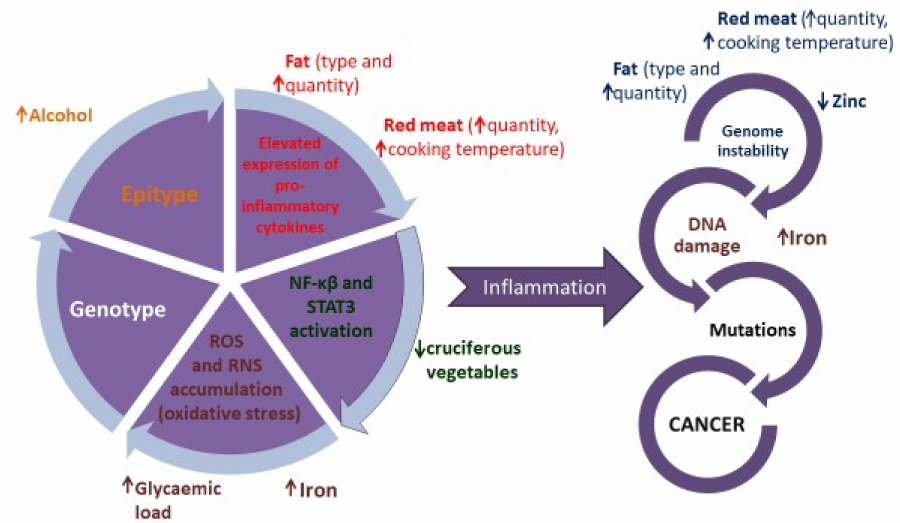
Figure 1. The influence of diet on the series of events that mediate inflammation-induced cancer initiation. The colour of the text links the nutrient / food to the mechanism of action. = high intake can be harmful and = low intake can be harmful. Abbreviations: NF- κβ —nuclear factor kappa-light-chain-enhancer of activated B cells; RNS—reactive nitrogen species; ROS—reactive oxygen species; STAT3 - Signal Transducers and Activators of Transcription